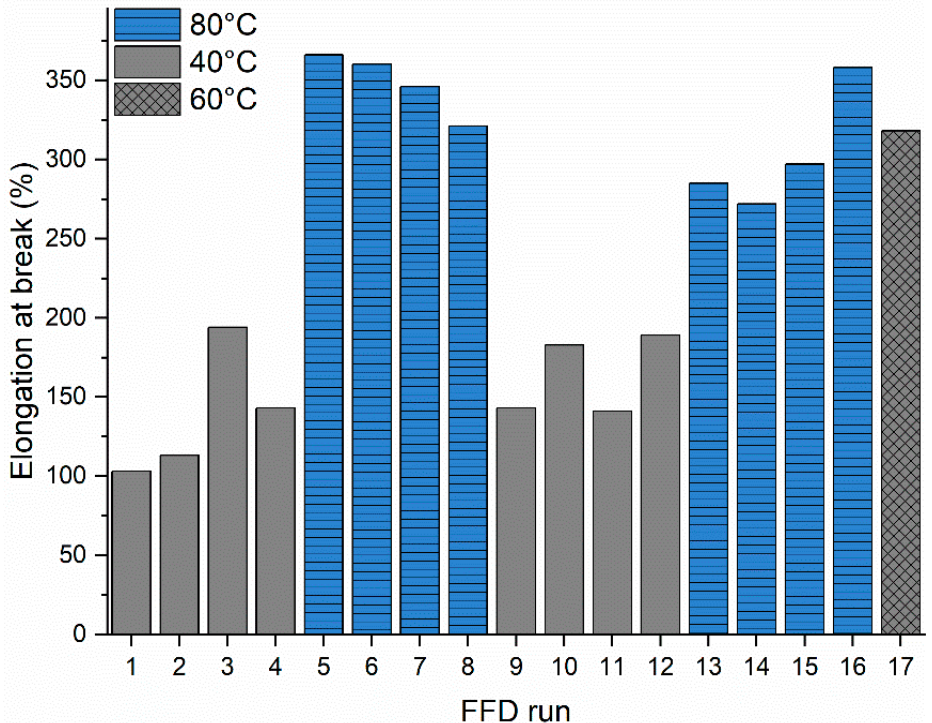
Figure 4. Individual value plot of the 17 run FFD for elongation at break ( ε ), grouped according to mold temperature M = 40 °C (grey), M = 80 °C (blue), and M = 60 °C center point run (grey, cross) showing increased elongation at break for high mold temperatures (only mean values are represented for clarity, statistical error is included in Table 4).